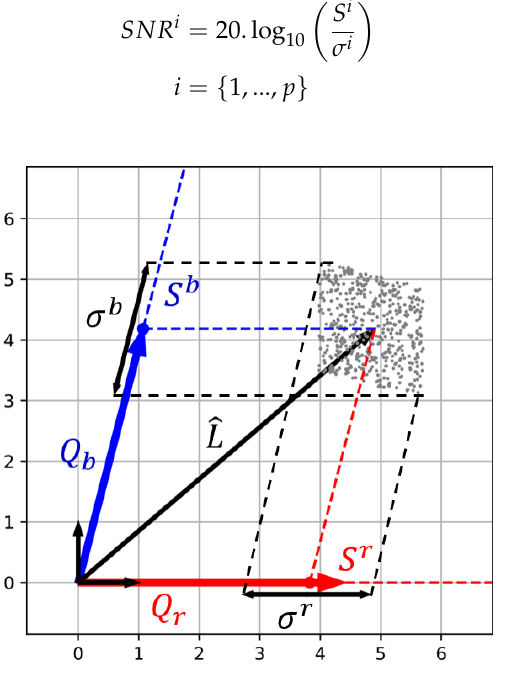
Figure 13. Projection of the uncertainty volume onto contravariant coordinates. Uncertainty in spectral reconstruction is given by contravariant noise σ r and σ b . When the angle between channel is smaller, the contravariant coordinates and SNR decrease. Spectral reconstruction becomes “more noisy”.